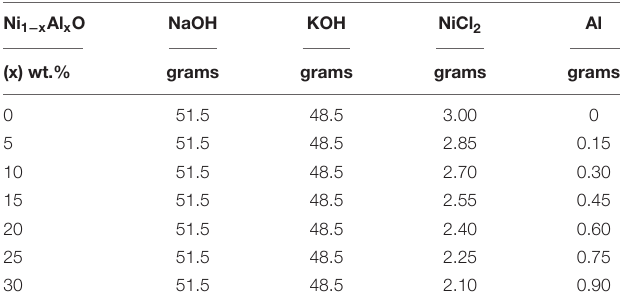
TABLE 1 | Estimation of various concentrations for the preparation of Ni 1 − x Al x O nanoparticles. Ni 1 − x Al x O